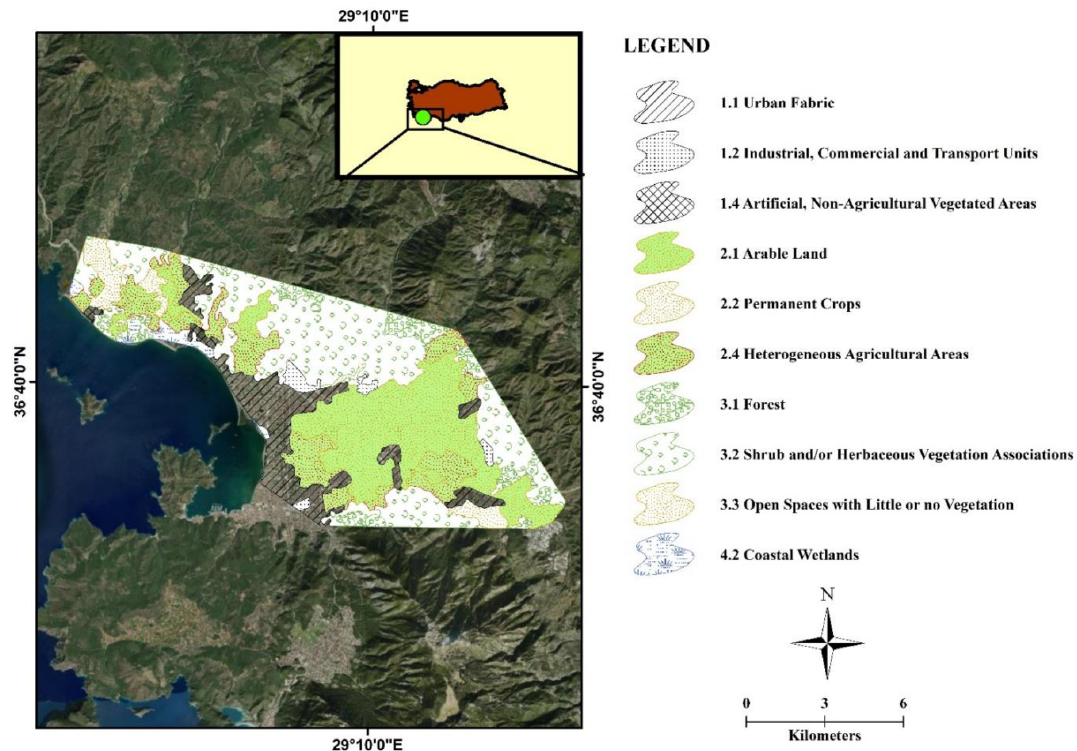
Figure 9. Land cover classification of computational domain according to CORINE 2018 Data (sources: Esri, Maxar, GeoEye, Earthstar Geographics, CNES/Airbus DS, USDA, USGS, AeroGRID, IGN, and the GIS User Community).